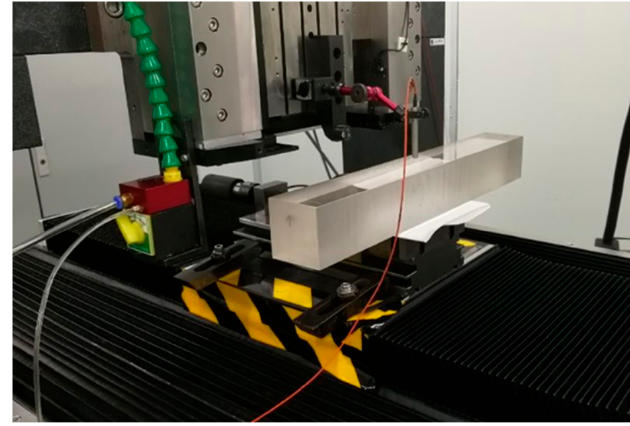
Figure 8. Straightness measurement in X -axis vertical direction.